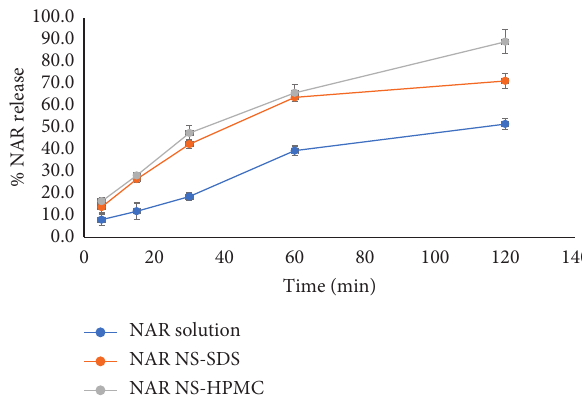
Figure 5: Comparative dissolution profile of naringenin and naringenin nanosuspensions in phosphate-buffered solution (pH 6.8) at 37 ± 0.5 ° C ( n �